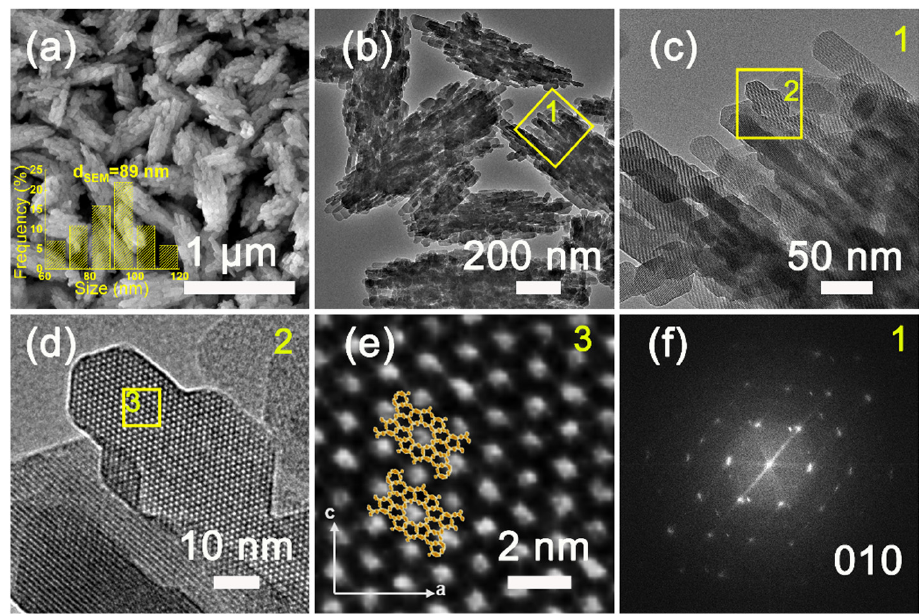
Figure 2. ( a ) SEM and ( b – e ) TEM micrographs (inset: size distribution), and ( f ) FFT diffraction pattern of H-Z5-PK3.